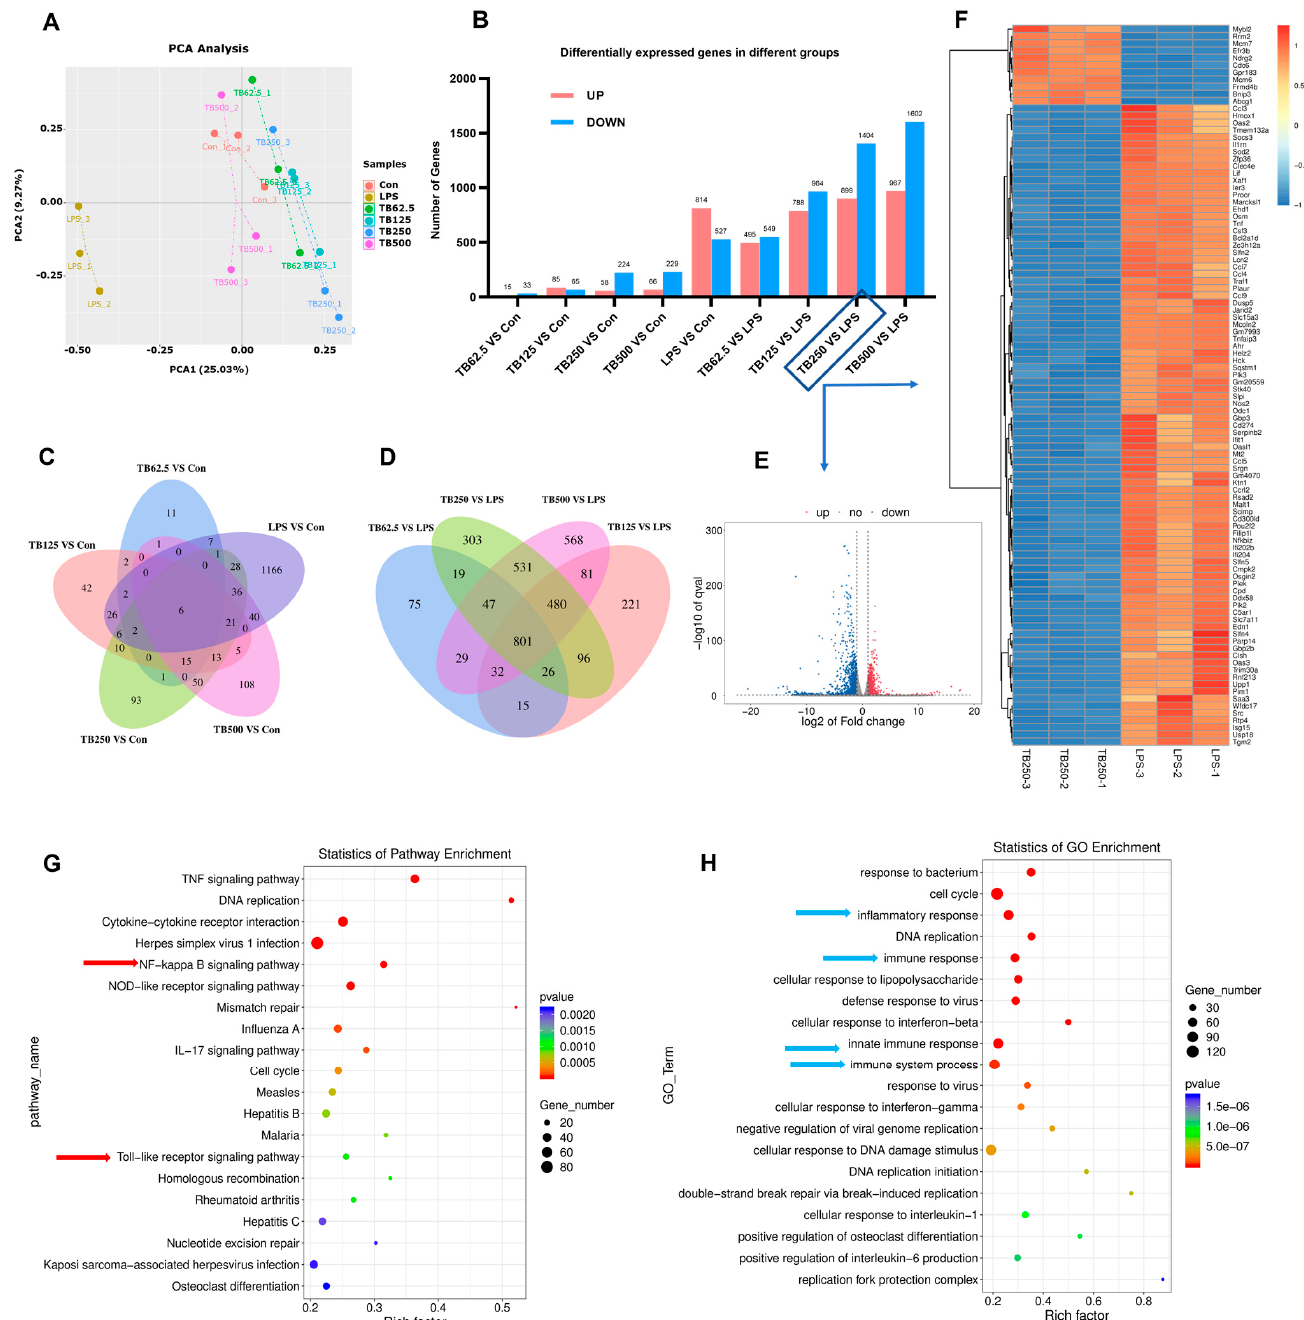
Figure 5. Results of cellular transcriptomics analysis. Data were extracted from RNA-seq results (three replicates per group). ( A ) PCA analysis of all groups. ( B ) Differentially expressed genes in different groups. ( C ) Venn analysis comparing genes in TB treatment groups vs. Con-group. ( D ) Venn analysis comparing genes in TB treatment groups vs. LPS group. ( E ) Volcano plots of RNA-seq data for 250 µ g/mL TB group vs. LPS group. ( F ) Heat map depicting the significantly differentially expressed genes for 250 µ g/mL TB group vs. LPS group. ( G ) KEGG pathway enrichment based on differential genes in 250 µ g/mL TB group and LPS groups (red arrow: NF- κ B and toll-like receptor signaling pathways). ( H ) GO enrichment based on differential genes in 250 µ g/mL TB group and LPS groups (blue arrow: functions related to inflammation and immunity).